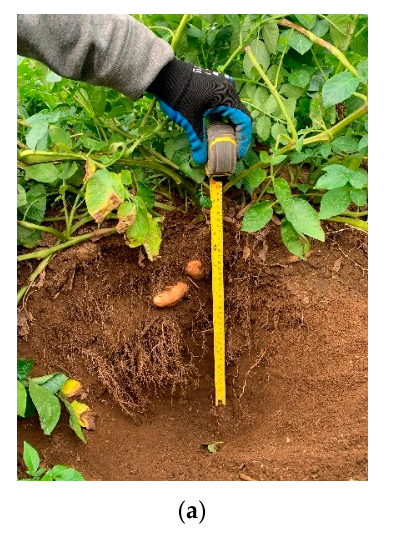
Figure 2. Data collection: ( a ) in situ root depth measurements, and the remote sensing data acquisition set-up (UAV—( b ) and camera—( c )). Table 1. Data collection characteristics per field.